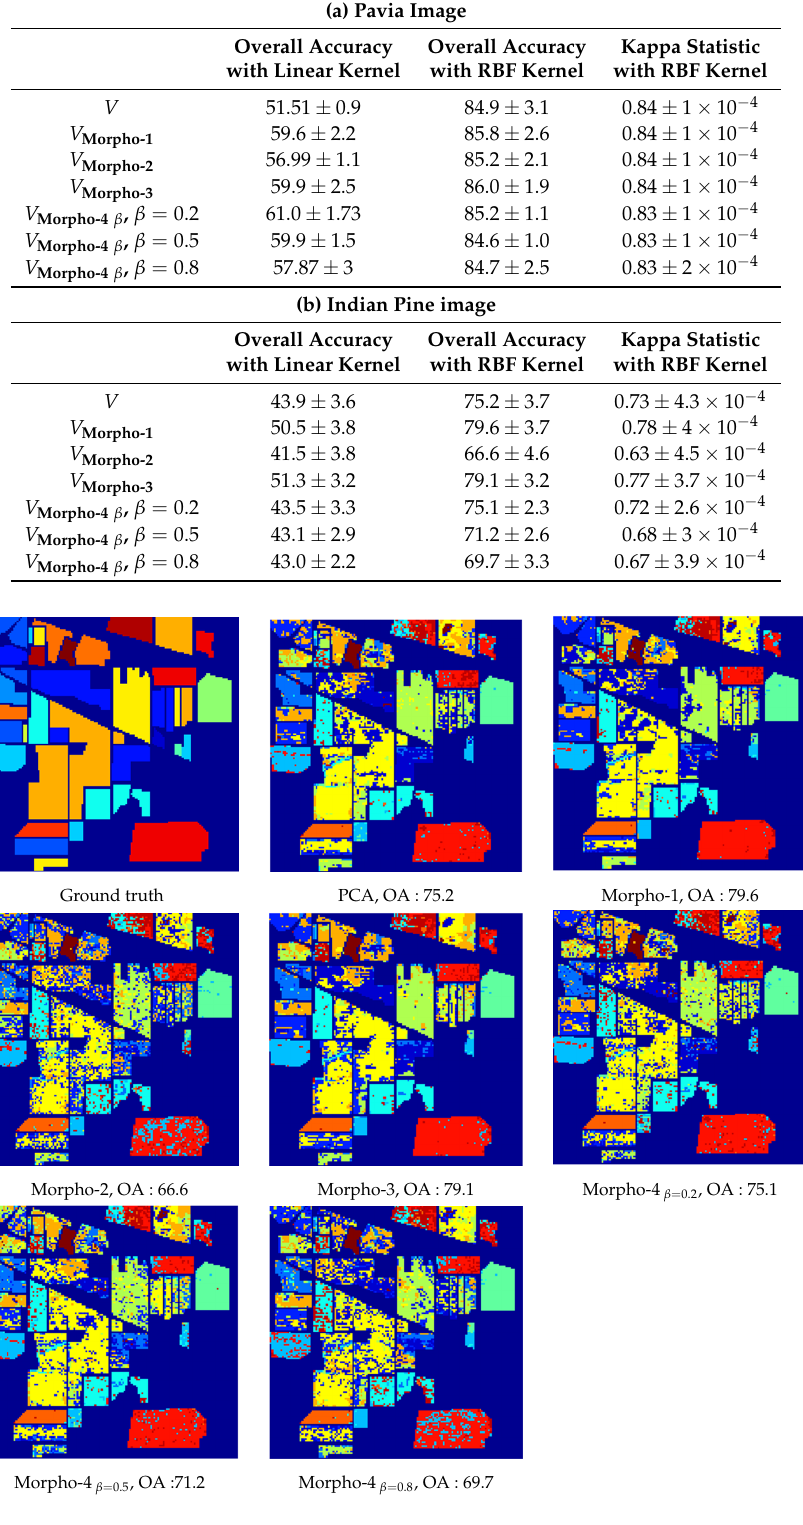
Figure 17. Results of supervised classification using least square SVM with a RBF kernel on Indian Pines hyperspectral image. Note the OA is the overall